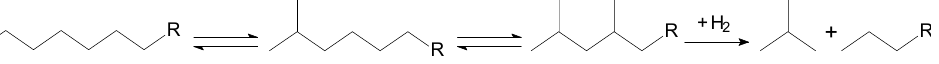
Figure 10. Hydroisomerisation and hydrocracking of n -alkanes. Isomerisation and cracking steps take place by dehydrogenation, acid catalysis and hydrogenation, which are not explicitly shown.